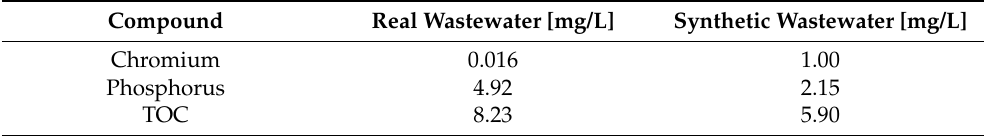
Table 1. Synthetic and Real Wastewater